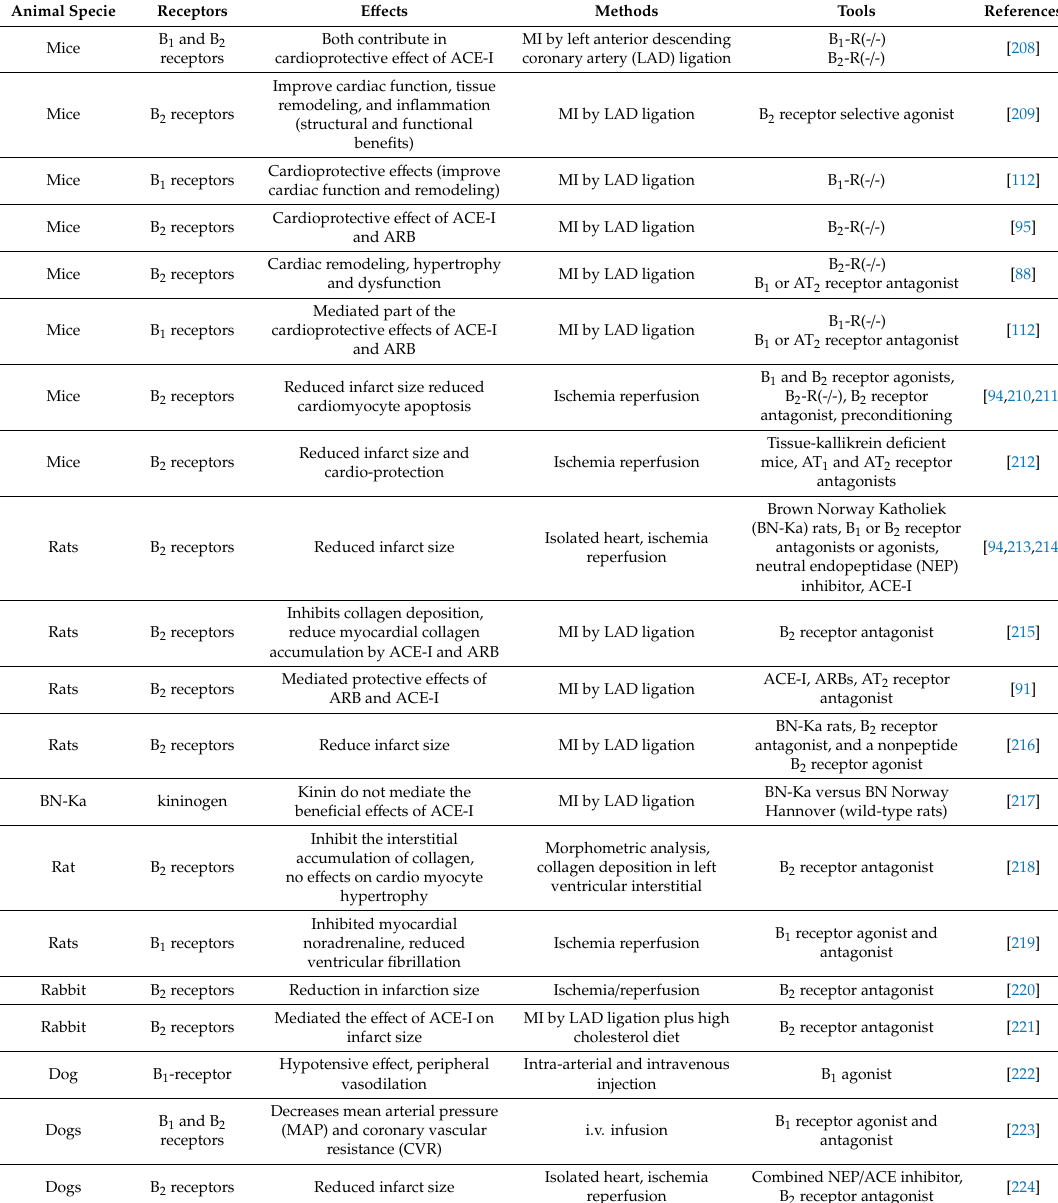
Table 1. Role of kinins in myocardial